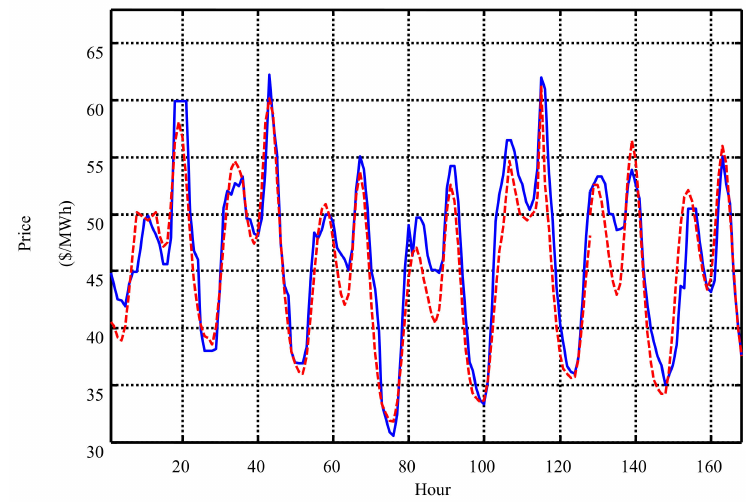
Figure 17. Weekly forecast of NYISO; continuous blue and dotted red line.